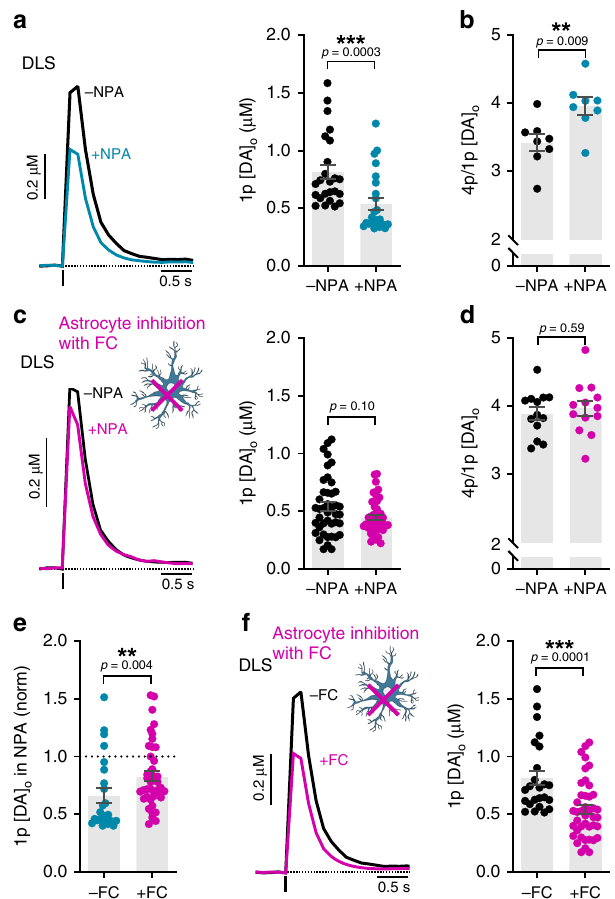
Fig. 6 GATs on striatal astrocytes regulate GABA inhibition of DA release in DLS. a – d Mean pro fi les of [DA] o and mean peak [DA] o in DLS evoked by a single electrical pulse ( 1p ) ( a , c ) or four pulses normalized to 1p ( b , d ) in the absence (black) and presence of GAT inhibitor NPA (blue or pink, 1.5 mM) in vehicle-treated control slices ( a , n = 24 observations/5 mice; b , n = 9 observations/5 mice) or in slices treated with astrocyte inhibitor fl uorocitrate (FC, 200 µ M) ( c , n = 42 observations/7 mice; d , n = 13 observations/7 mice). e Mean peak [DA] o evoked by 1p in the presence of NPA (1.5 mM) normalized to control conditions in control slices (blue) or fl uorocitrate-treated slices (pink) from a and c . f Mean peak [DA] by 1p in the absence of NPA in control slices ( − FC ) and in fl uorocitrate- treated slices ( + FC ) from a and b . DH β E (1 μ M) present throughout. Mann – Whitney U tests ( a, c, e, f ) and two-tailed Student ’ s unpaired t -tests ( b , d ). ** p < 0.01, *** p < 0.001. Error bars are ±SEM. Source data are provided as a Source Data fi